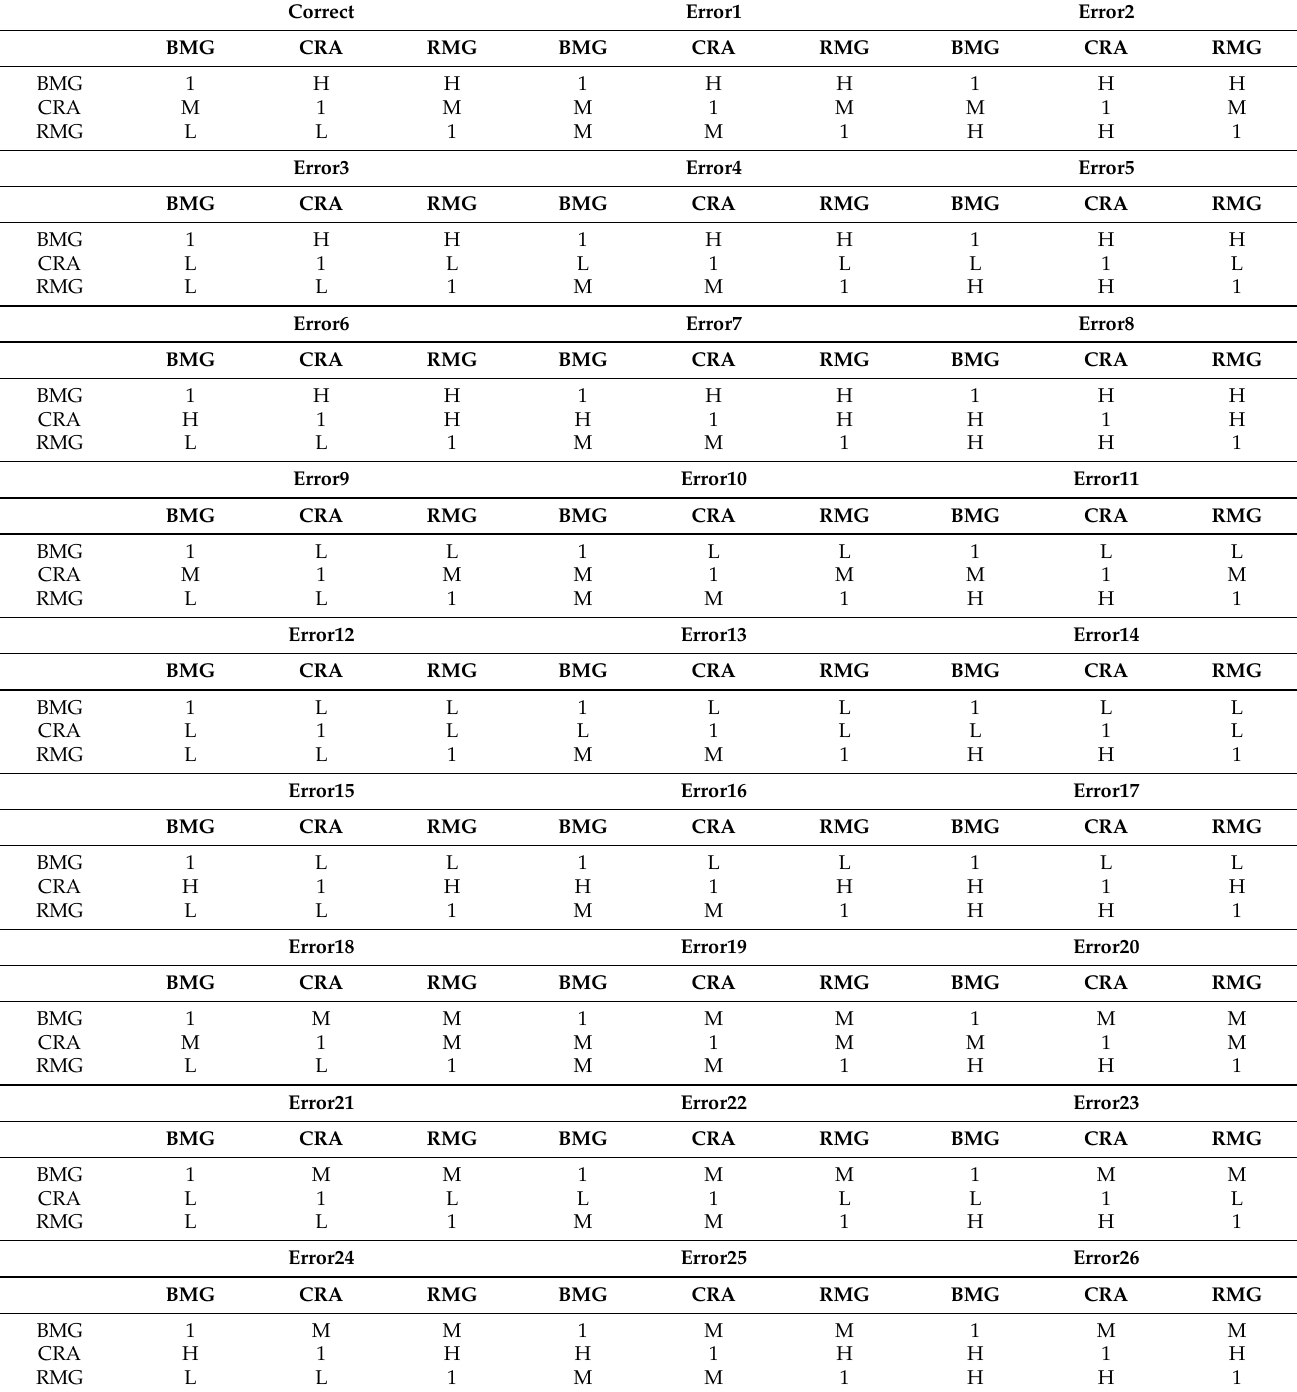
Table A1. Different cost matrix configurations. Here, there is one correct configuration from domain knowledge (Correct), and the other 26 (Error1–Error26) are not correct. H: High , M: Medium , L: Low